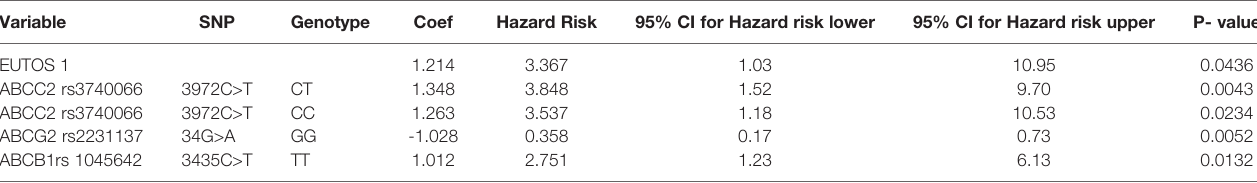
TABLE 3 | Cox regression model for SNPs and MR3.